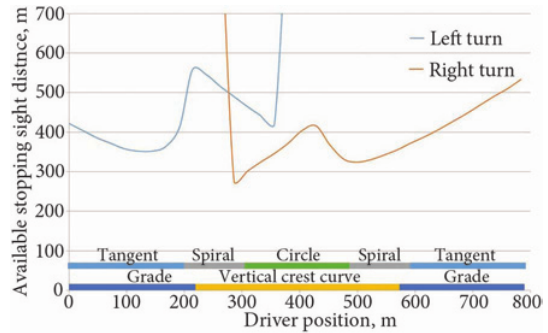
Fig. 4. Available stopping sight distance profile without lateral obstructions